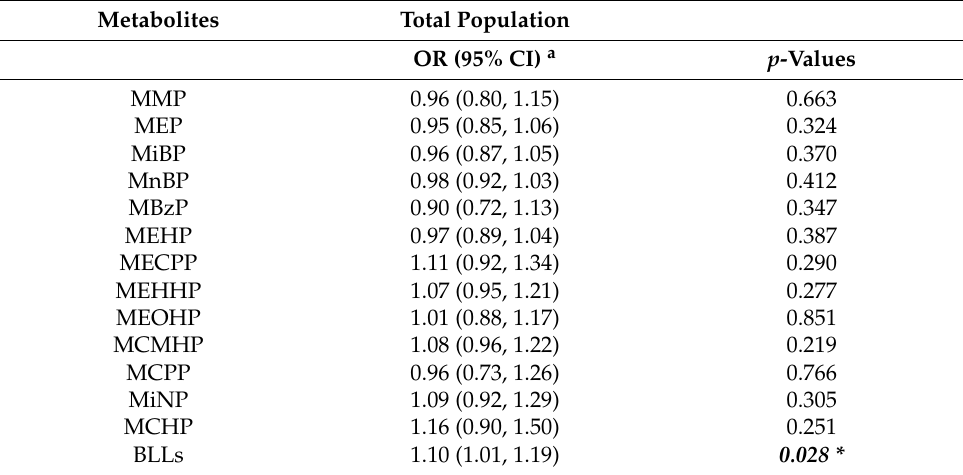
Table 3. Adjusted ORs for urinary phthalate metabolites, blood lead levels, and thyroid